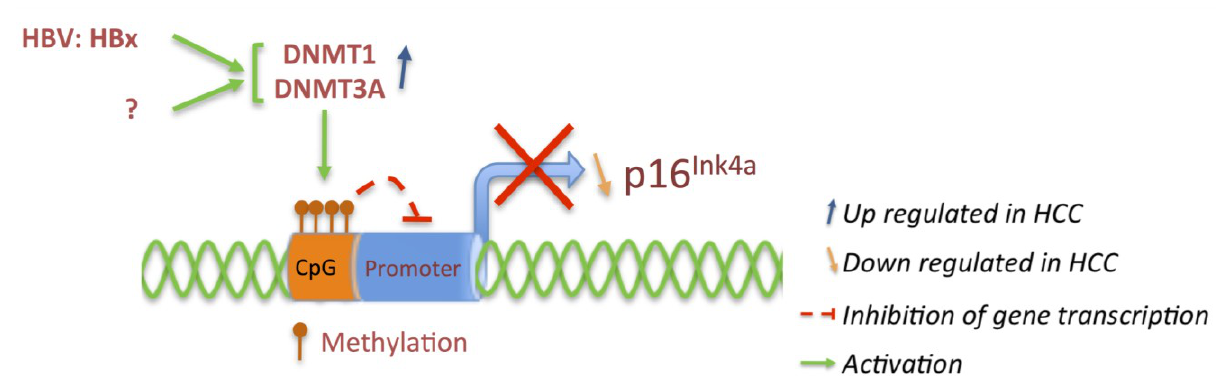
Figure 3. p16 Ink4a expression is down regulated in HCC through hypermethylation of CpG islands as a result of increased expression of DNA methyltransferase DNMT1 and DNMT3A associated with hepatitis B virus expression or due to other